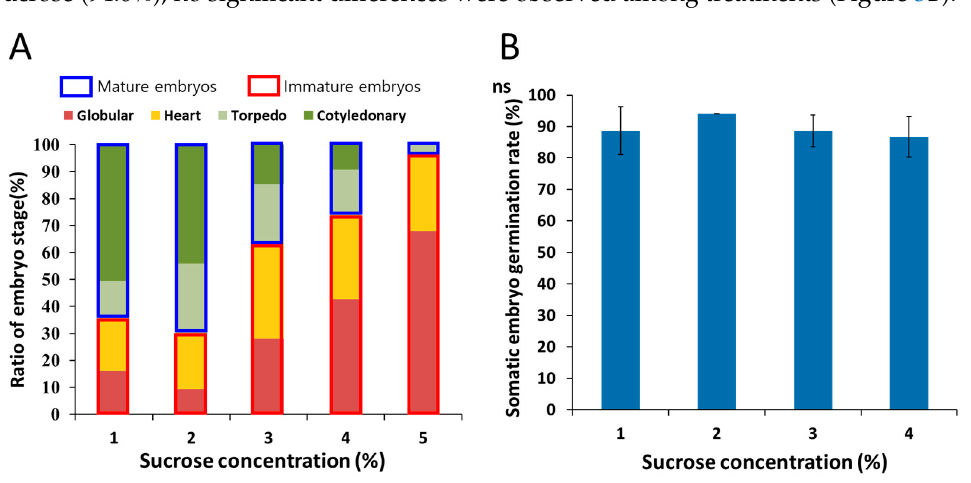
Figure 3. Effect of sucrose concentration on ( A ) somatic embryo maturation and ( B ) germination of P. ginseng . Data were recorded 30 days after somatic embryos were transferred to maturation or germination media. Values represent the ratios of embryo stages and means ± standard error of germination rates measured in three independent experiments, each consisting of ten explants. ns: non-signi fi cant determined by ANOVA.